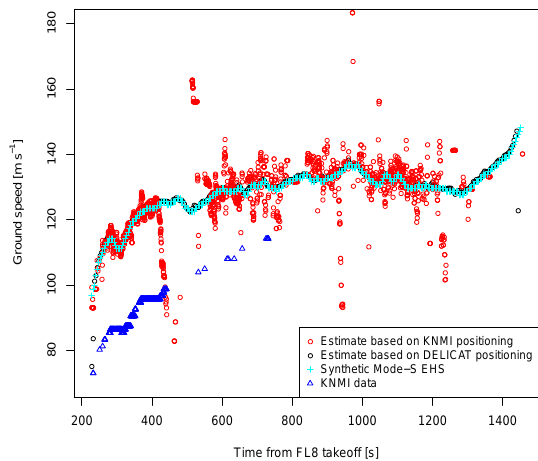
Figure 4. Comparison of flight paths as recorded by the KNMI re- ceiver (red dots) and resulting from the processing of the DELICAT data (black dots) for a fragment of FL9. The 2km error can be at- tributed to IRS drift which is of the order of 3km per hour. IRS was calibrated prior to each flight.